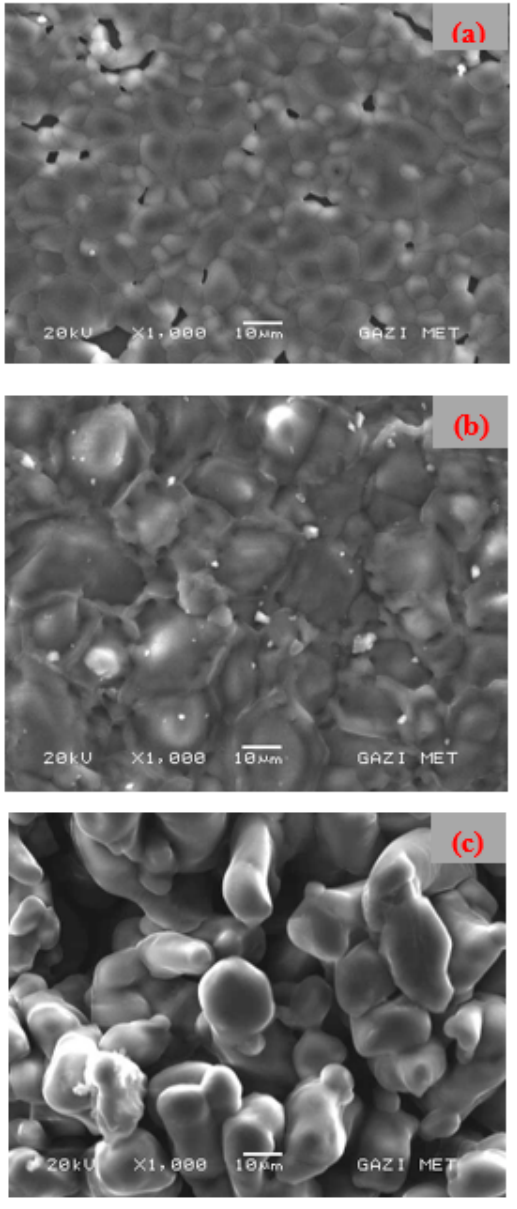
Figure 3. SEM micrographs of SPEs with different salt concentrations: ( a ) SPE-10, ( b ) SPE-30, and ( c ) SPE-50.